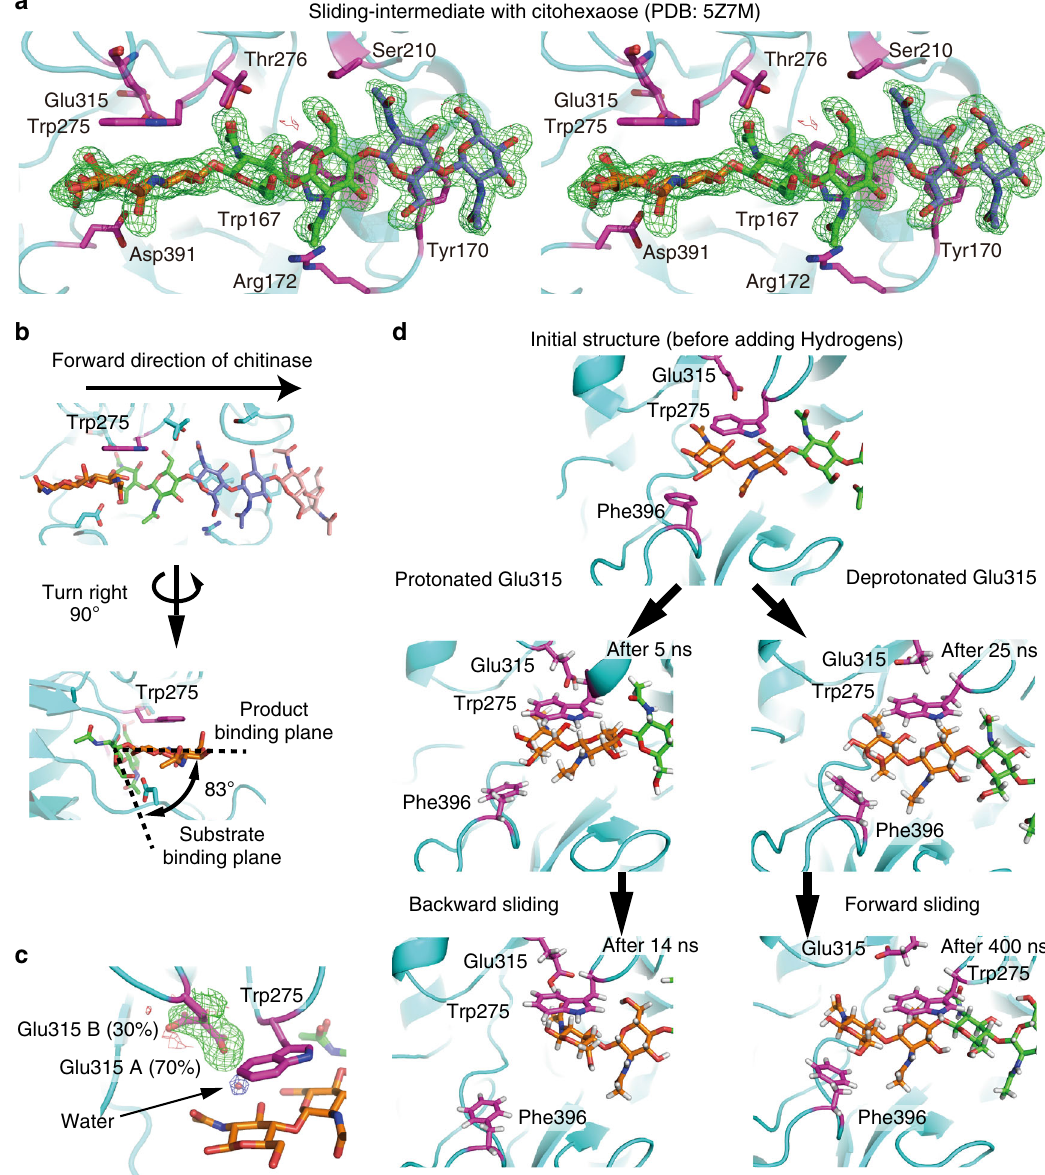
Fig. 4 Structural and MD simulation analyses of chain sliding of SmChiA. a Cross-eyed stereo view of the omit map of chitohexaose molecule in the Sliding- intermediate structure (PDB ID: 5Z7M) shown at 3 σ ; green: positive; red: negative. Substrate-interacting amino acid residues are shown by purple. b Product- and substrate-binding planes in the Michaelis complex-like structure of inactive D313A mutant (PDB ID: 1EIB); inter plane angle is 83°. c Omit map of Glu315 side chain in the Sliding-intermediate structure shown at 3 σ ; green: positive; red: negative. 2 F obs − F calc map of water molecule is also shown in 1.5 σ (arrow). d Snap shots of MD simulation showing forward and backward chain slidings from the Sliding-intermediate structure. Structures before (25 ns) and after (400 ns) forward sliding with deprotonated Glu315 are shown on the right, and those before (5 ns) and after (14 ns) backward sliding with protonated Glu315 are shown on the left. Trp275, Glu315, and Phe396 were shown by stick. Structures were aligned with Trp275 as the centre of